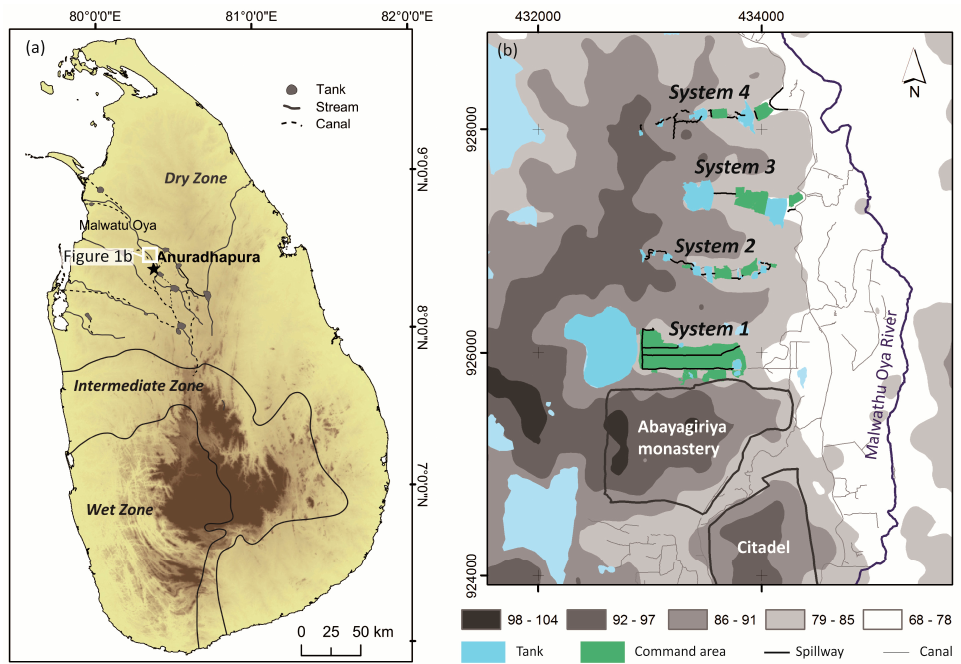
Figure 1. ( a ) Ancient irrigation system within the dry zone of Sri Lanka (modified after Seneviratna, 1987 [30]); ( b ) Location of the four investigated tank systems north of Anuradhapura.